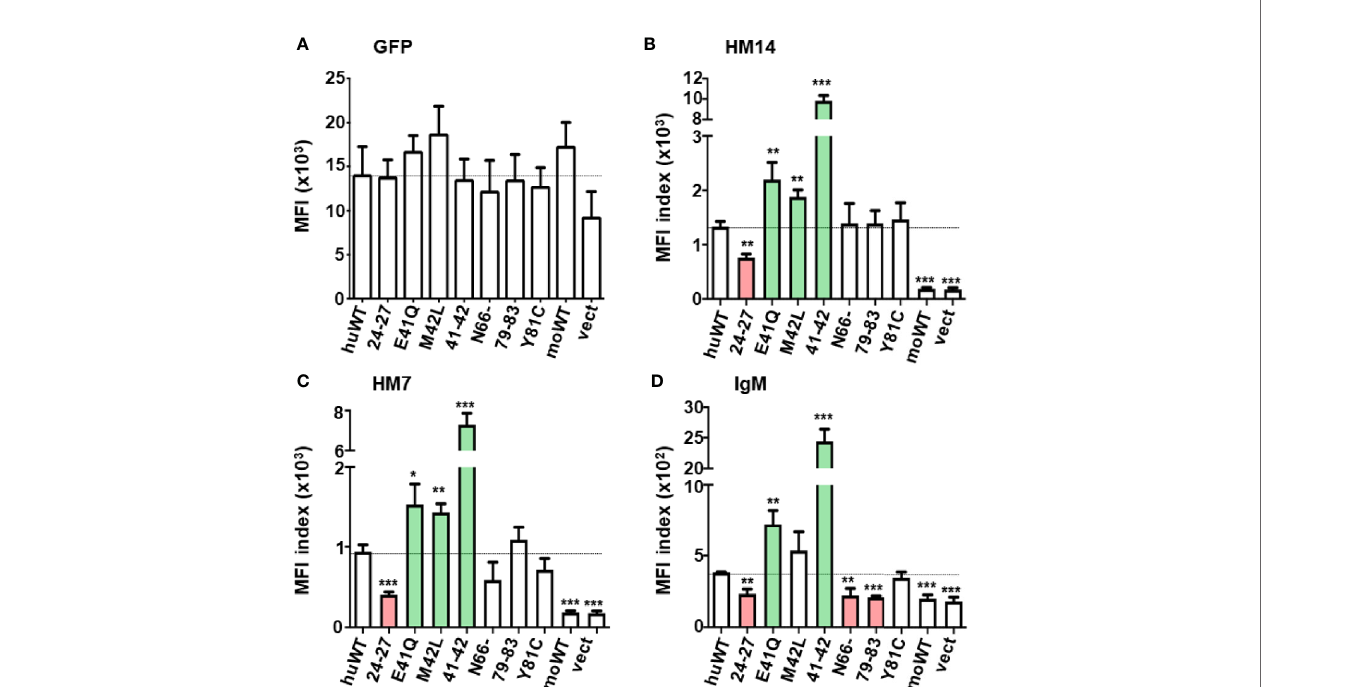
FIGURE 3 | Quantitative assessments of the GFP and FcµR expression and the IgM binding activity by seven N-terminal FcµR mutants. MFI indices of the expression of GFP (A) , the reactivity of HM14 (B) and HM7 (C) and the binding of IgM (D) in each transductant were plotted as mean ± 1 SD from three independent experiments described in Materials and Methods. Lines correspond with the MFI index of huWT transductant. * P < 0.05, ** P < 0.01, *** P < 0.001 when compared to the huWT